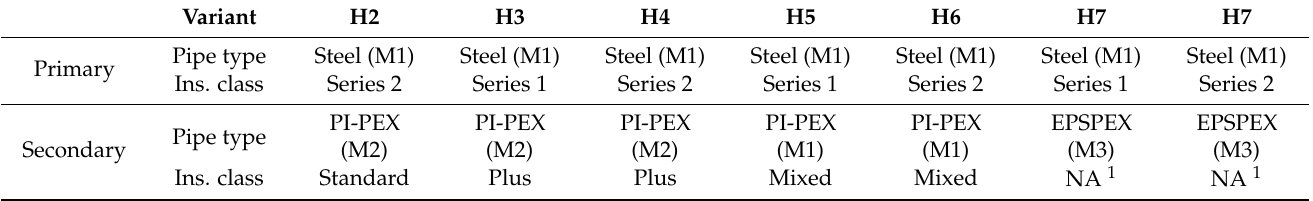
Table 6. Hybrid variants—Overview of different pipe combinations used to simulate variations (H1–H8) of the hybrid distribution concept. The pipe types are listed according to their application in either the primary or the secondary network. Abbreviations: ins = insulation and ref. = reference.